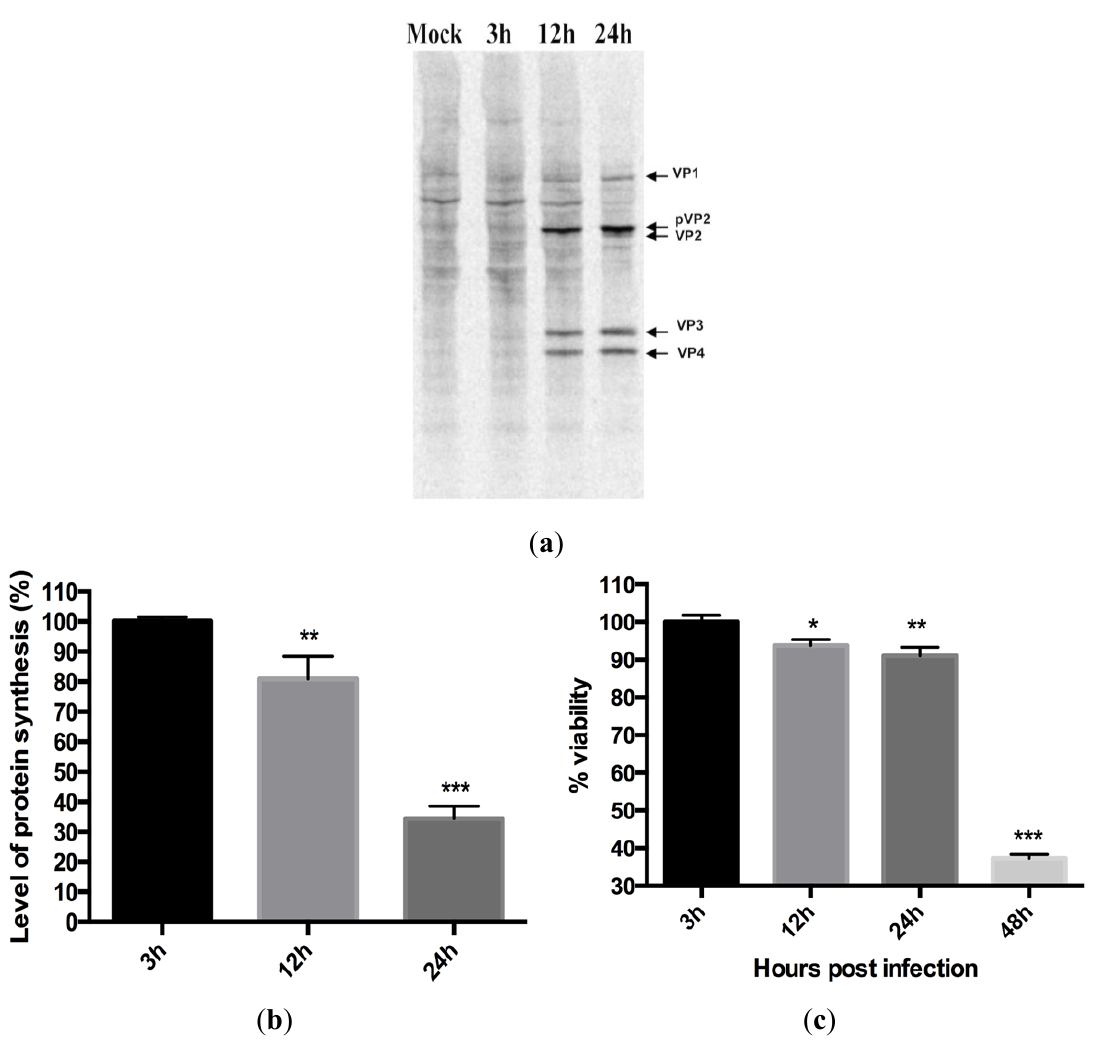
Figure 2. Infectious pancreatic necrosis virus induced inhibition of protein synthesis in CHSE 214 cells. Cells were first infected and, at indicated times, proteins synthesized were labeled using S 35 Methionine and then harvested. ( a ) Prepared lysates were subjected to SDS-PAGE, blotted onto a PVDF membrane and autoradiographed in storage phosphor cassettes before analysis using the Typhoon. The numbers represent time in hours post infection; ( b ) Levels of protein synthesis expressed as percentages of the mock-infected cells after measurement of mean density protein amounts of three different bands using ImageQuant software (GE Healthcare). The results are representative of four independent experiments. * p < 0.05; ** p < 0.01; ( c ) Cell viability post IPNV infection. Cells were infected with IPNV and cell viability was assayed at the indicated time post infection using CellTiter 96® AQueous One Solution assay (promega). The percent viability was calculated as described in the methodology section. Bars represent the average of 8 measurements taken from two independent infections ± SD. * p < 0.05, ** p < 0.01, *** p <